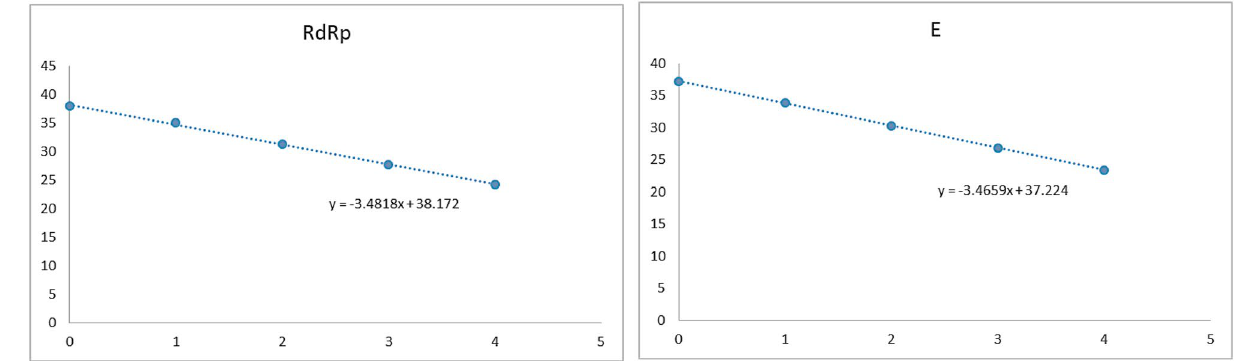
Figure 1. Analysis of linearity of RT-qPCR results targeting SARS-CoV-2 RdRp and E genes in plasmid DNA containing cloned target sequences.